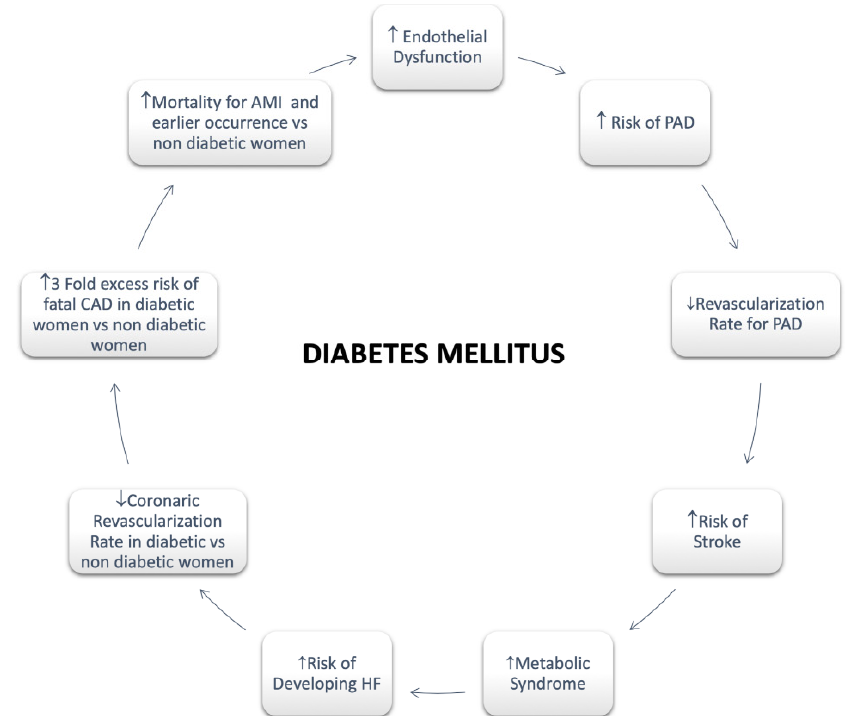
Figure 2. Diabetes Mellitus in Women. Abbreviations: Peripheral artery disease; HF: Heart Failure; CAD: Coronary Artery Disease; AMI: Acute Myocardial Infarction.